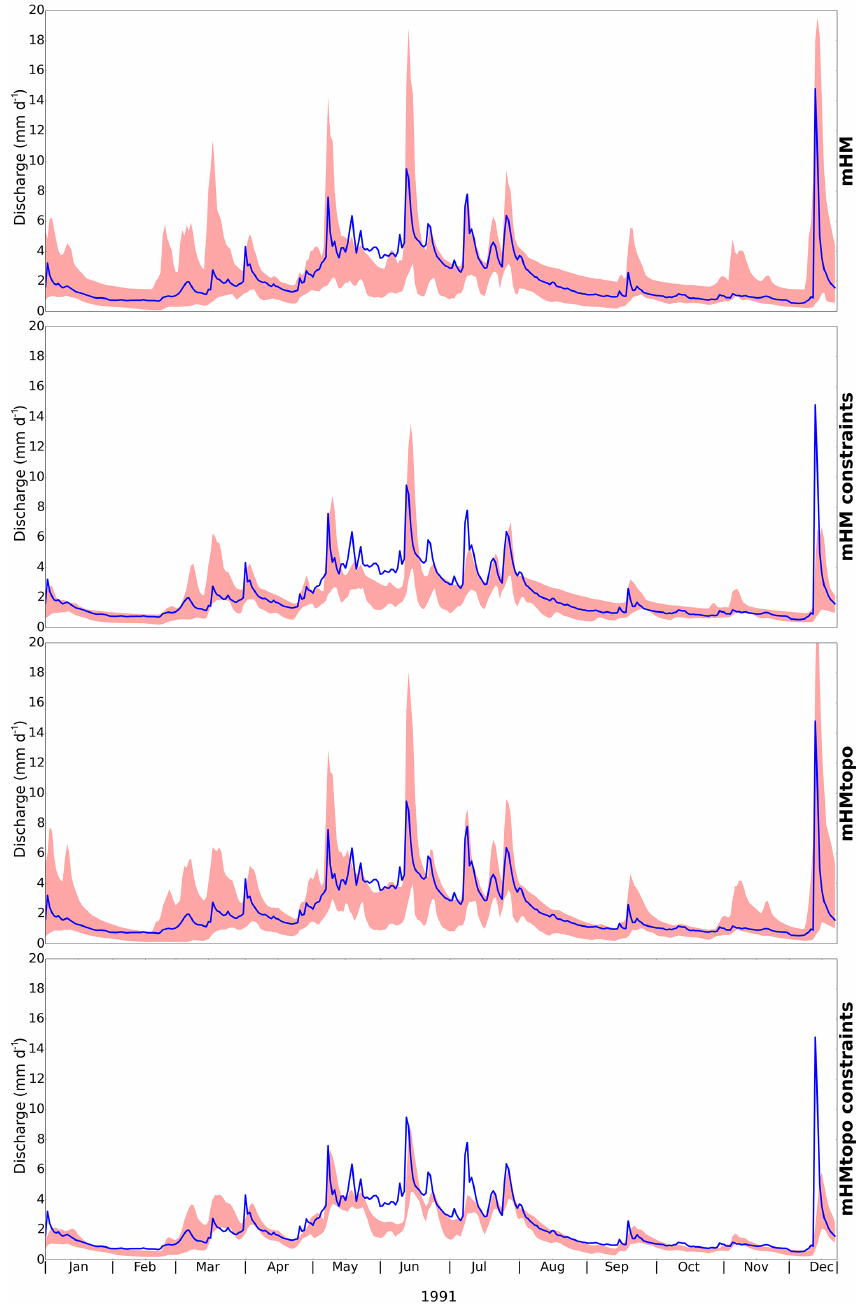
Figure 9. Hydrographs for the Loisach catchment, with, respectively, the hydrographs for mHM, mHM with constraints, mHMtopo and mHMtopo with constraints. The red shaded areas represent the envelope spanned by all feasible solutions, whereas the blue line corresponds to observed